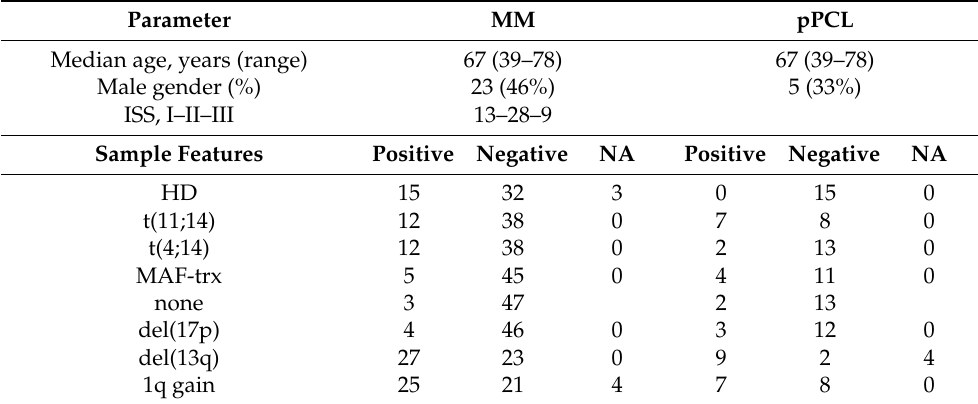
Table 1. Molecular characteristics of 50 MM and 15 pPCL patients. NA = not